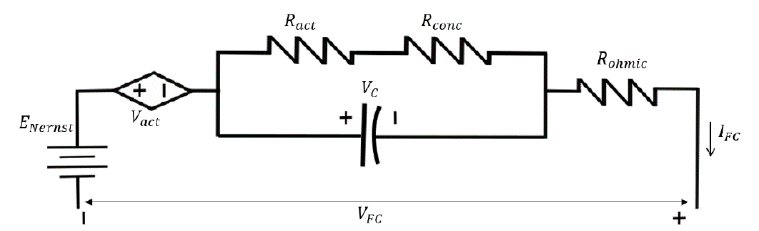
Figure 4. Electrical circuit model of the PEMFC (Proton-Exchange Membrane Fuel Cell).